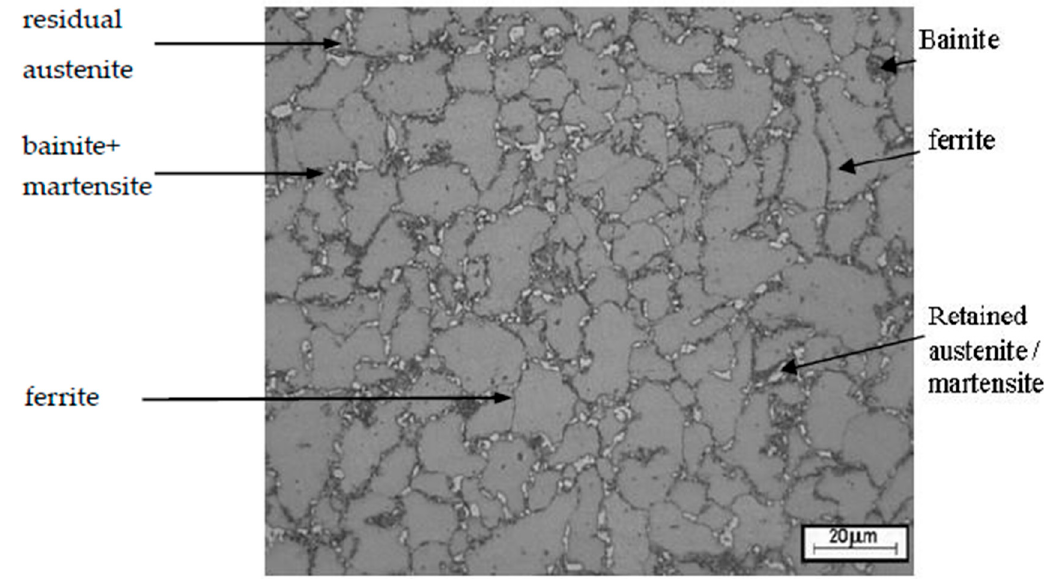
Figure 1. Transformation induced plasticity (TRIP) steel microstructure after a two-stage heat treatment conducted according to optimized process parameters as etched with the Lichtenegger and Blöch reagent (29% of retained austenite).